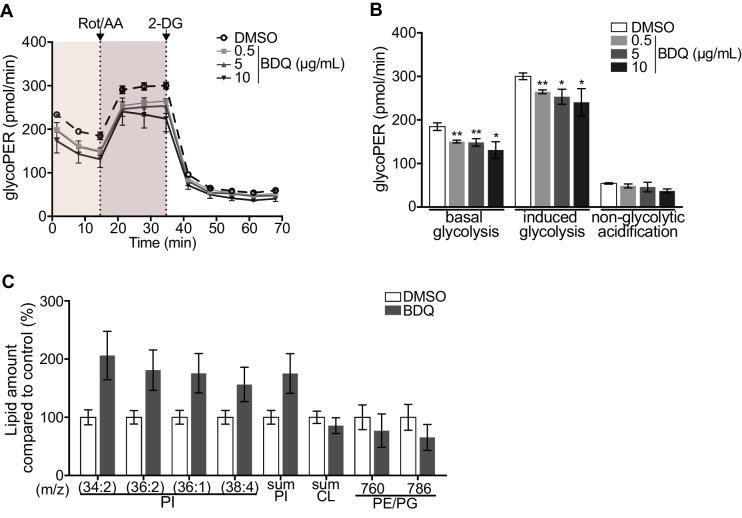
BDQ modulates the metabolism of naïve macrophages.(A–B) The Glycolytic Rate Assay was performed in macrophages, in the presence of rotenone/antimycin A (Rot/AA) and 2-deoxy-D-glycose (2-DG), respectively inhibitors of mitochondrial electron transport chain and of glycolysis (one-way ANOVA test). One representative experiment (of two) is shown. (C) Lipid profile of cells by MALDI-TOF (unpaired two tailed Student’s t test). PI: Phosphotidylinositol; CL: Cardiolipids; PE: Phosphatidylethanolamine; PG: Phosphatidylglycerol. Numbers correspond to mass-to-charge ratio (m/z). Cells derived from three donors were analyzed. Error bars represent the mean ± SD and significant differences between treatments are indicated by an asterisk, in which *p<0.05, **p<0.01.